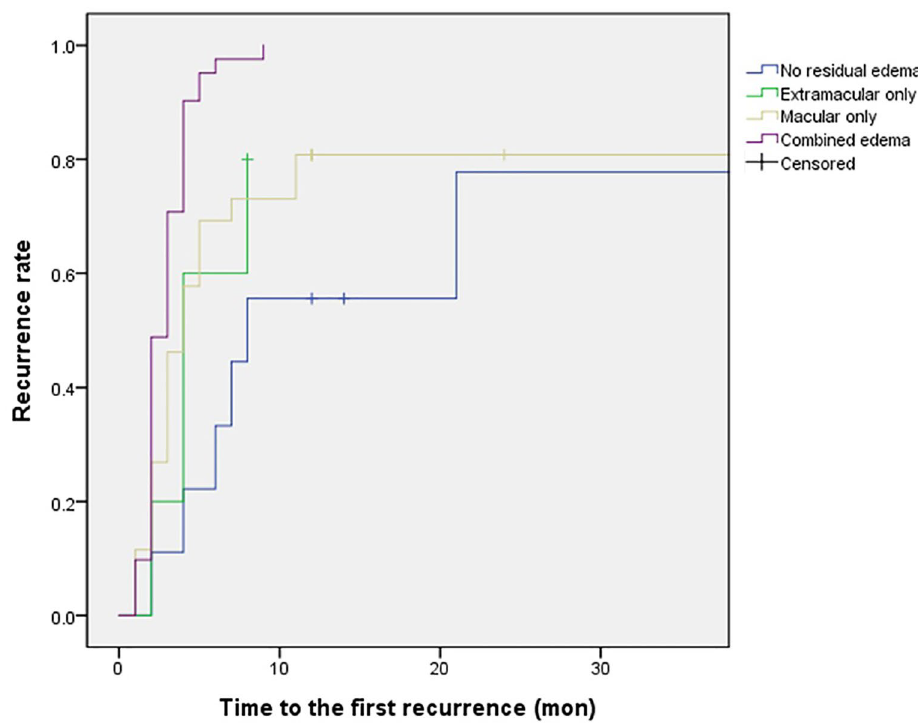
Figure 4. Kaplan–Meier plot of time to the first recurrence in four groups of patients separated based on pattern of retinal edema 1 month following anti-vascular endothelial growth factor (VEGF) therapy for macular edema.